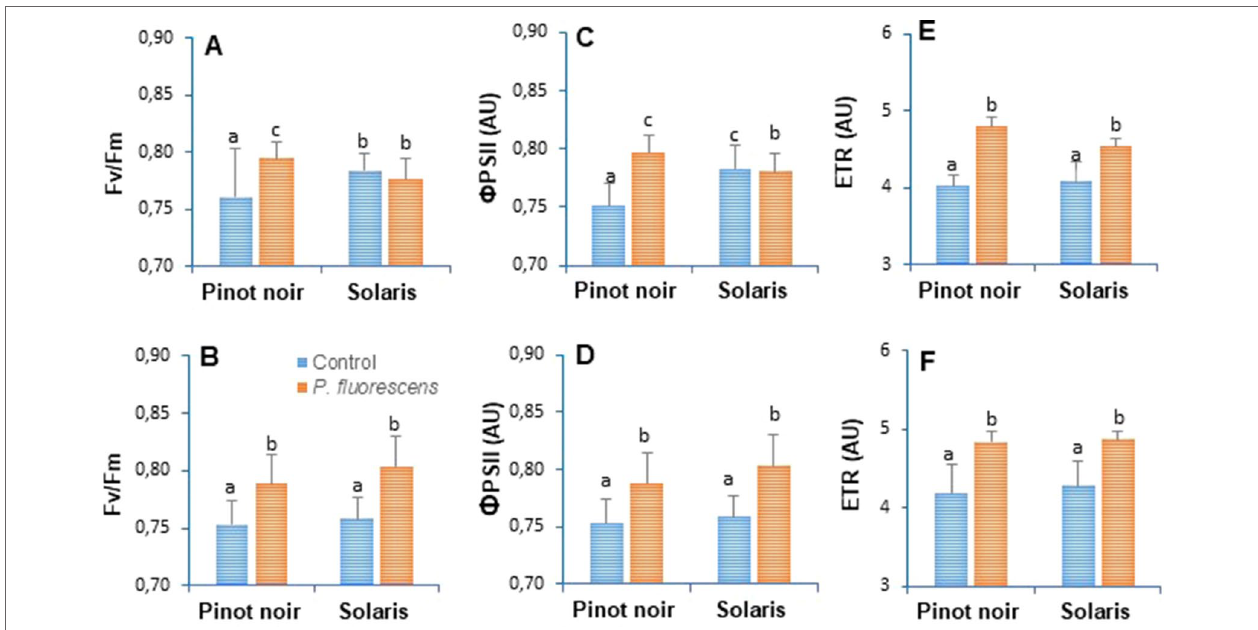
FIGURE 3 | Pseudomonas fluorescens PTA-CT2 stimulates photosynthetic efficiency in both grapevine cultivars Pinot noir and Solaris. Plants were treated at the root level with P. fluorescens at 10 7 CFU g −1 of soil, and 2 weeks later, the maximum photochemical efficiency of the photosystem II (PSII) (Fv/Fm, A and B ), photochemical yield of PSII ( Φ PSII, C and D ), and relative photosynthetic electron transport (ETR, E and F ) were determined by pulse amplitude-modulated (PAM) fluorimeter. Data expressed in arbitrary units (AU) of chlorophyll fluorescence are the means from three independent experiments performed in 2016 (A, C, E) and 2017 (B, D, F) , and vertical bars indicate standard deviation. Different letters indicate statistically significant differences between the treatments (ANOVA Tukey test, P <